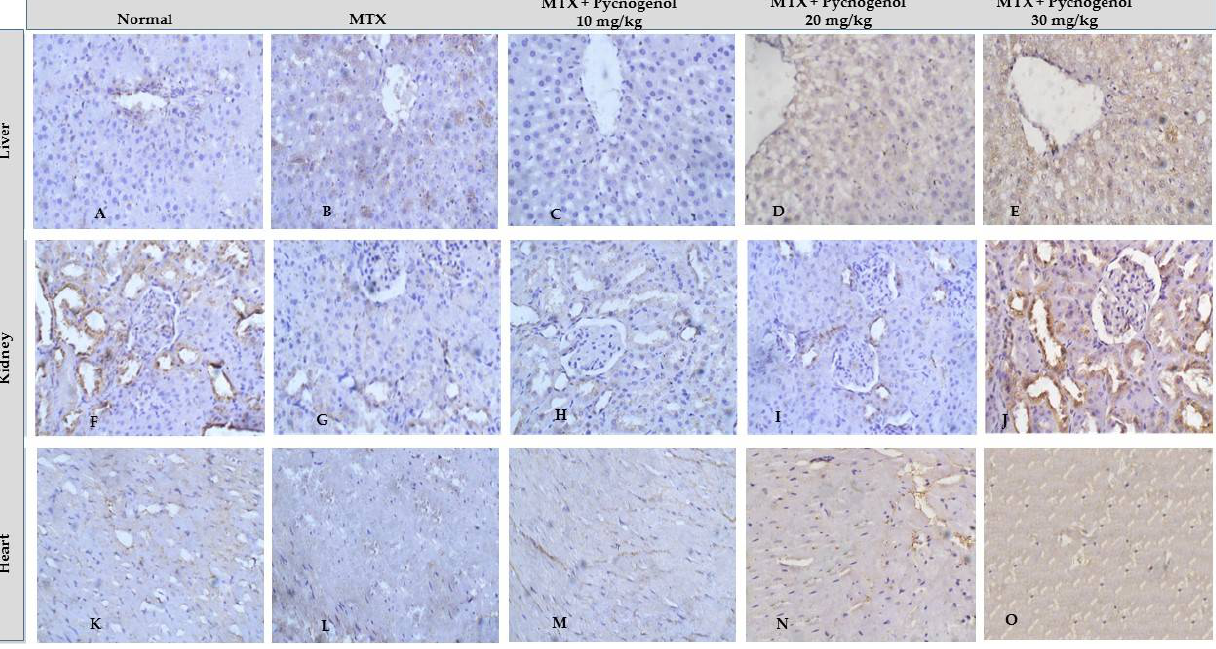
Figure 10. Immunohistochemical staining with IHC-P53 of heart ( A – E ), liver ( F – J ), and kidney ( K – O ) tissue. Differences assessed by Kruskal–Wallis test at p = 0.05.